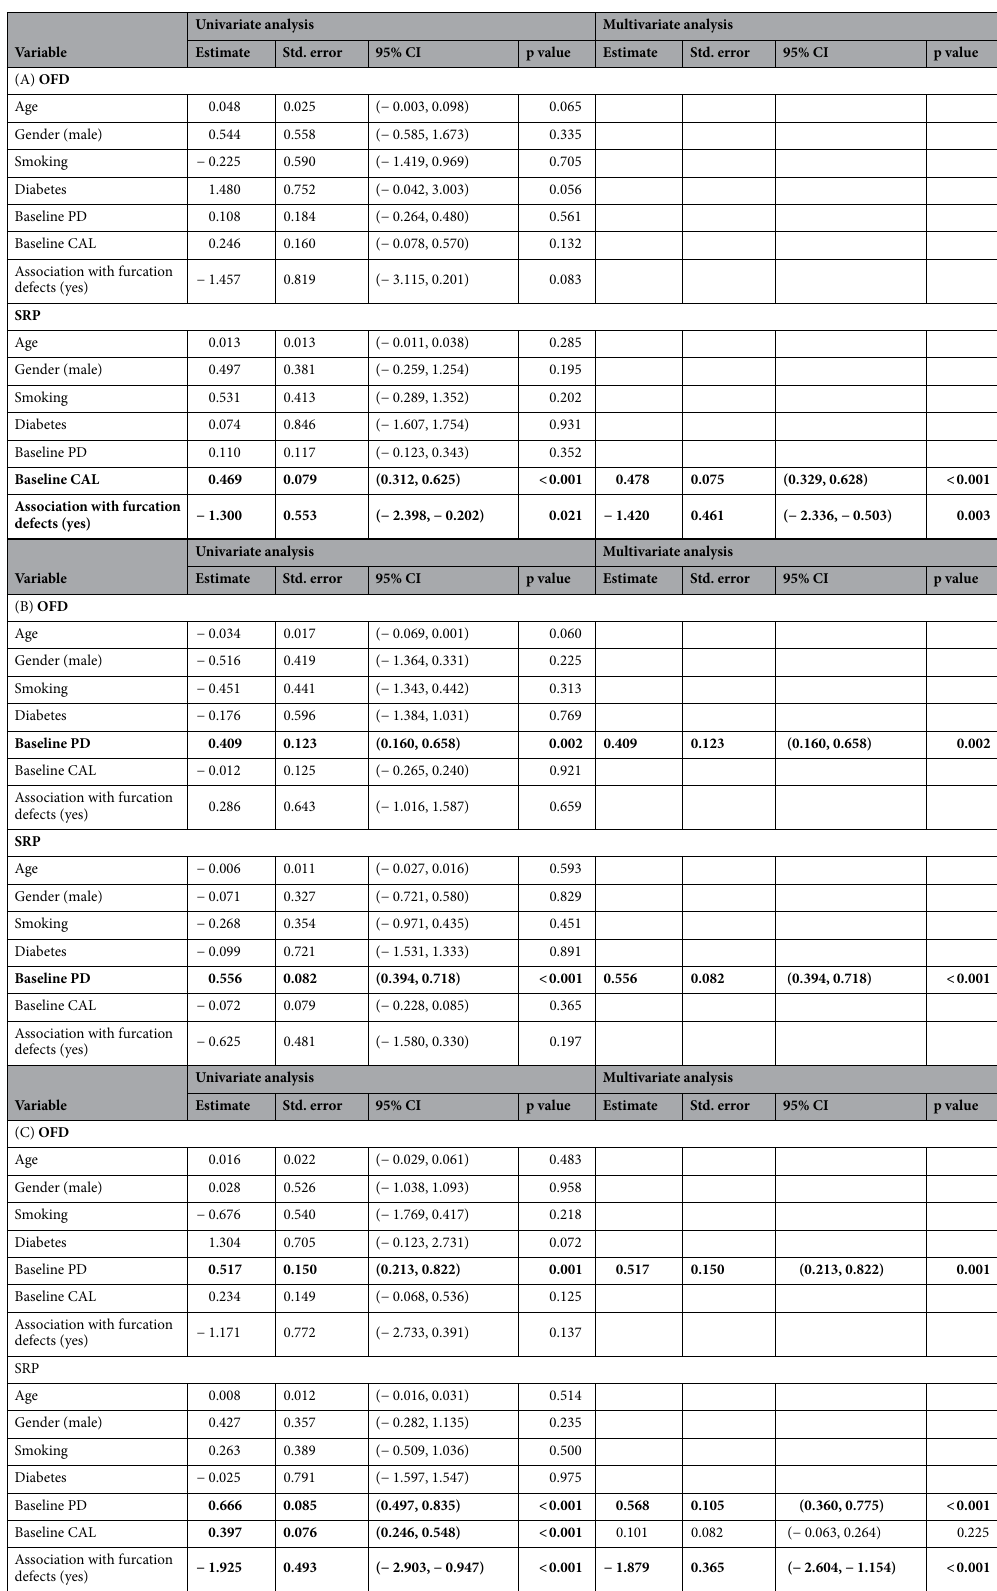
Table 2. Results of the regression models evaluating the effect of different variables on the CALs (2A), REC (2B) and PD (2C) of the treated defects at the 3–6 months re-evaluation appointment. The values in bold signifies statistical significance; CI, confidence intervals. Data related to the presented variables was available for all 132